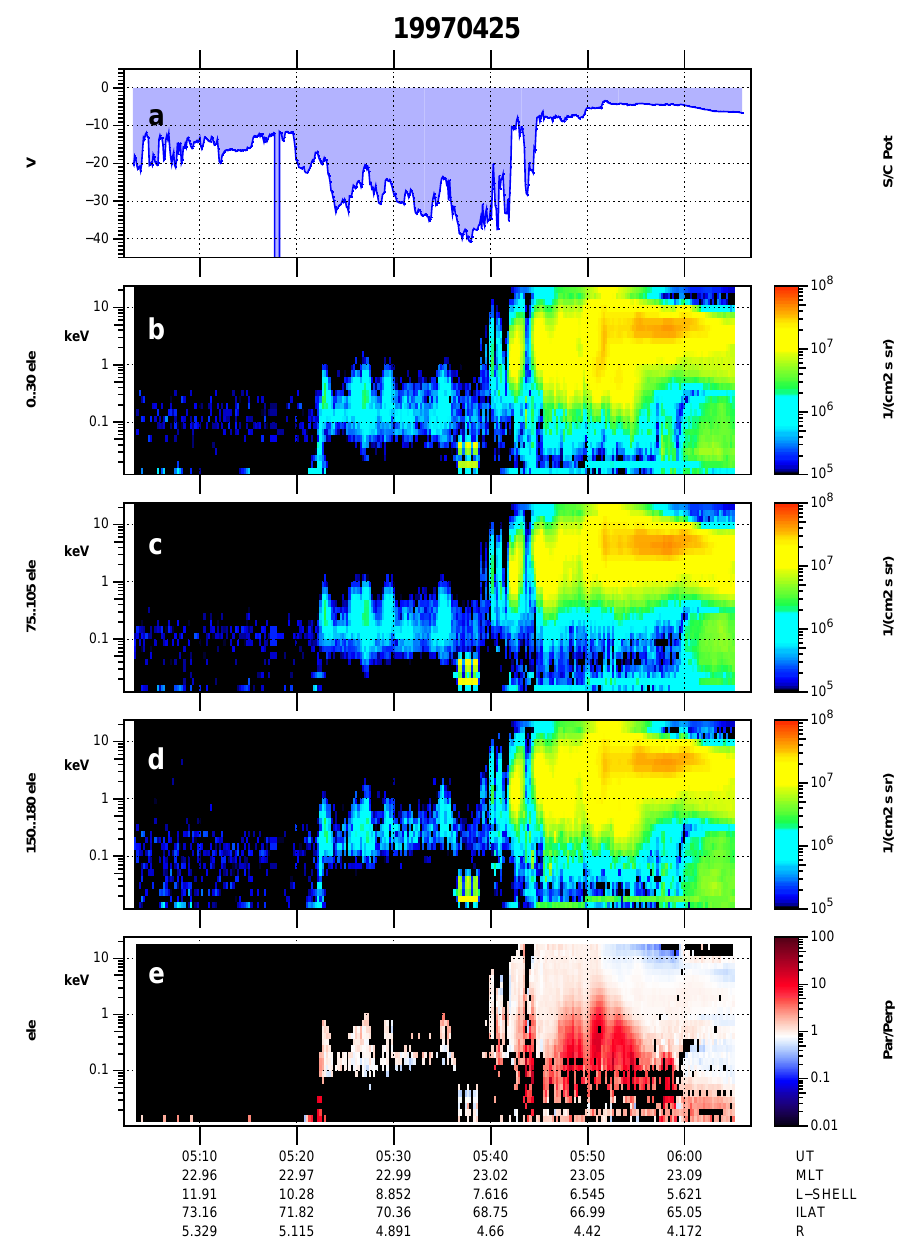
Fig. 8. Polar data for 25 April 1997, 5:03–6:07UT. EFI spacecraft potential (a) , HYDRA downgoing (b) , perpendicular (c) and upgoing (d) electron differential energy flux, and ratio between parallel and perpendicular fluxes (e) . The satellite moves from the polar cap into the auroral zone